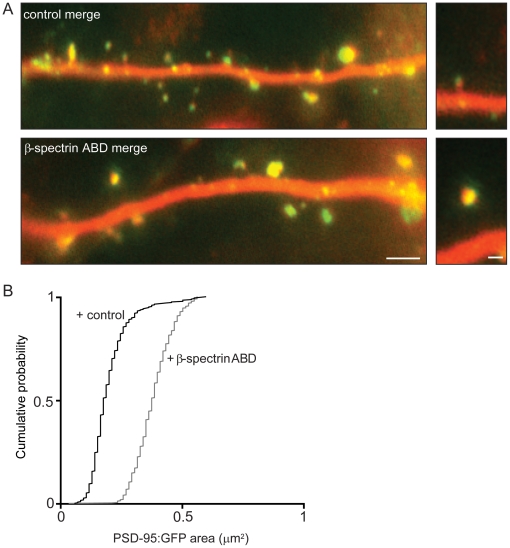
Expression of the ABD of βI-spectrin increases the size of the PSD.
A, Merged images from CA1 pyramidal neurons in hippocampal slice cultures co-transfected with PSD-95 fused to GFP (green) and mCherry (red), with or without an unlabelled βI-spectrin ABD construct. The areas of the clusters of PSD-95 in the heads of spines expressing the ABD of βI-spectrin were larger than in cells expressing PSD-95 alone. Scale bar = 4 µm (left), 1 µm (right). B, Cumulative probability plot showing that the area of the PSD was significantly larger in spines expressing PSD-95-GFP together with the ABD of βI-spectrin than in spines expressing PSD-95-GFP alone (n = 400 spines/4 neurons/condition; p<0.05, K-S test).